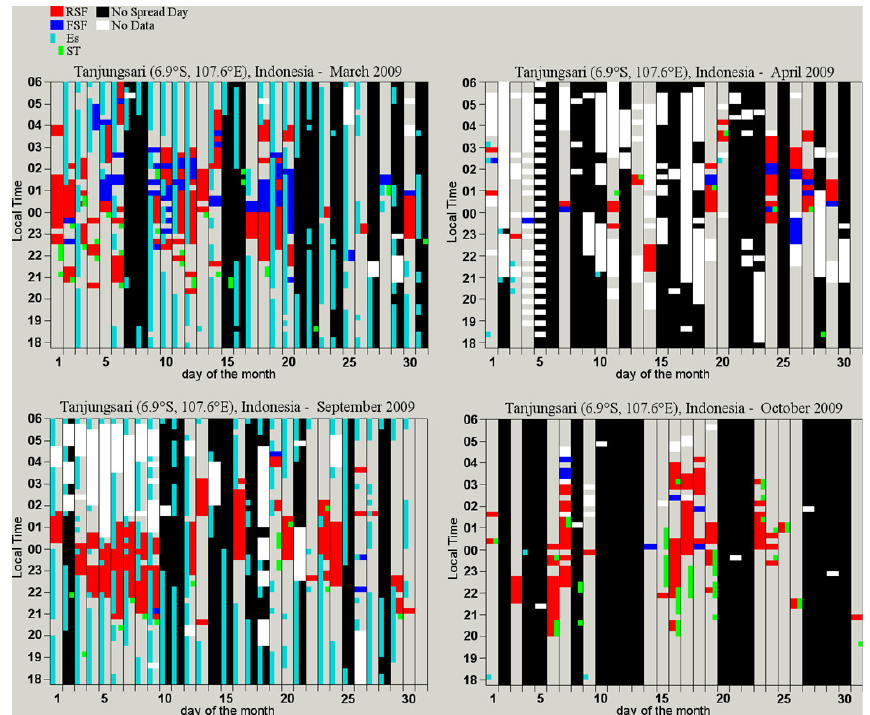
Fig. 6. Same as Fig. 5 for Tanjungsari, Indonesia. Cyan means presence of a general Es layer not specifically